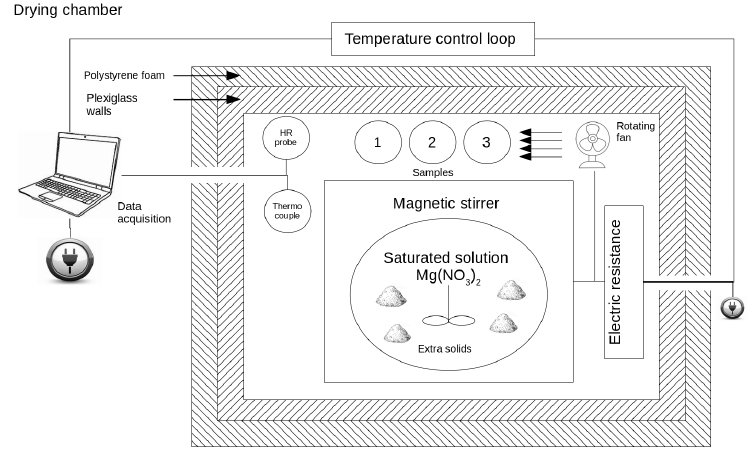
Figure 1. A sketch of the drying